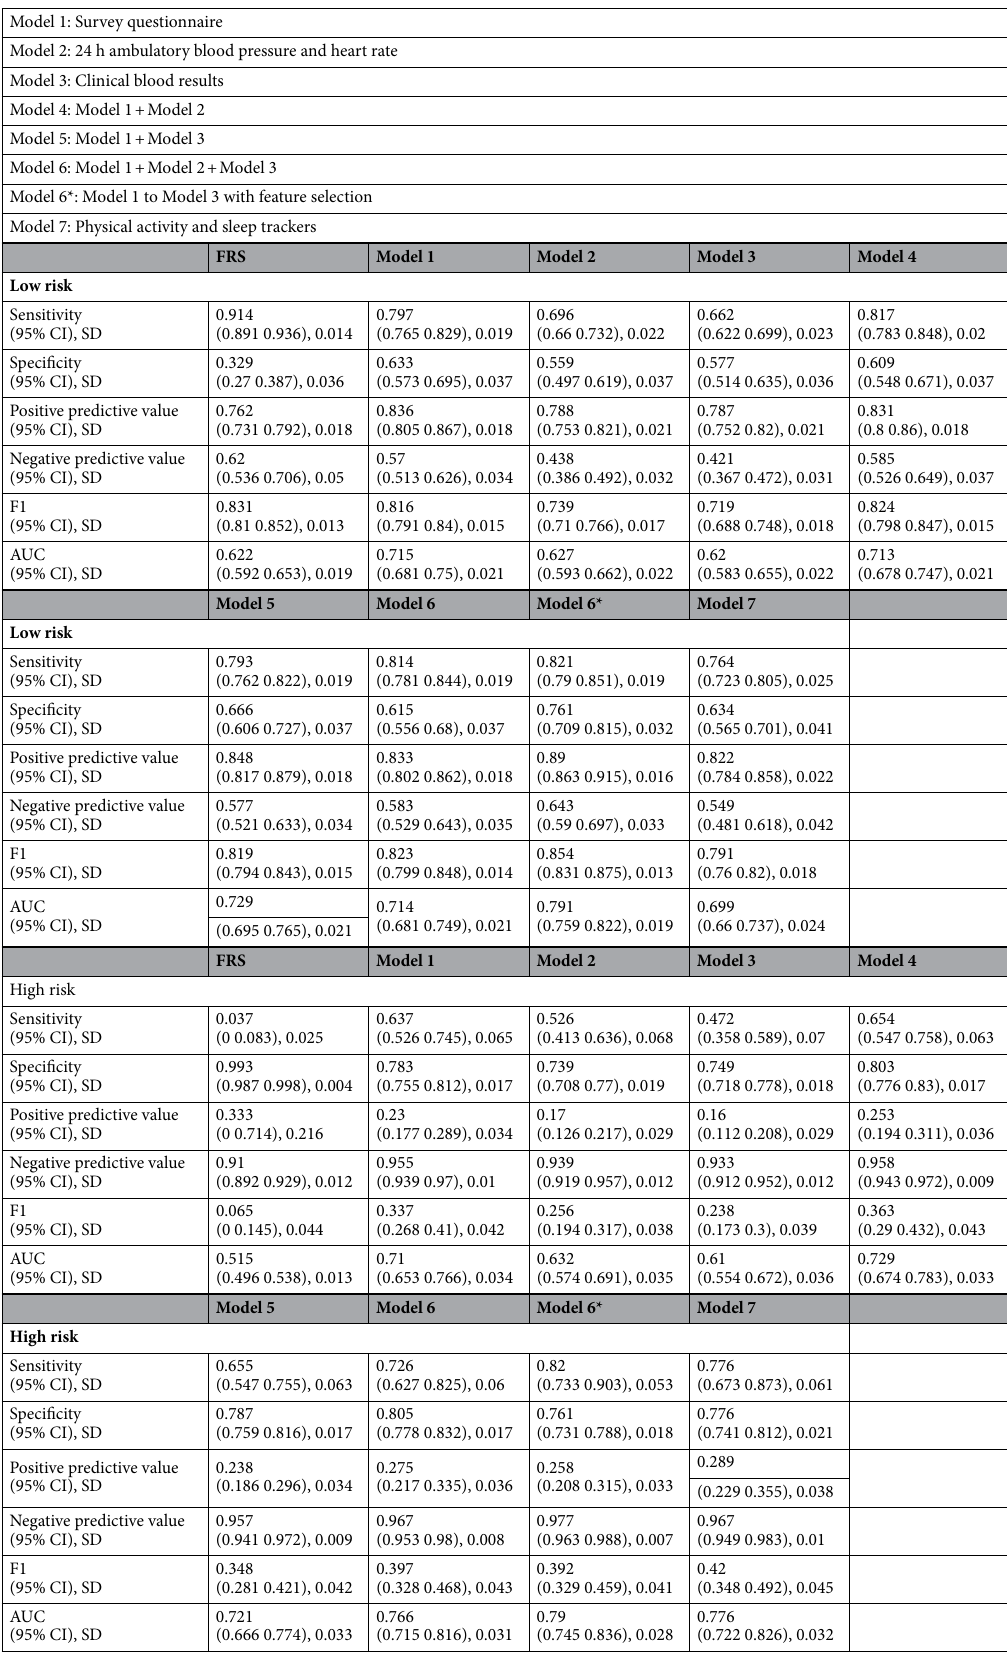
Table 6. Performance of conventional Framingham Risk Score and MLA models by variable groups in low risk